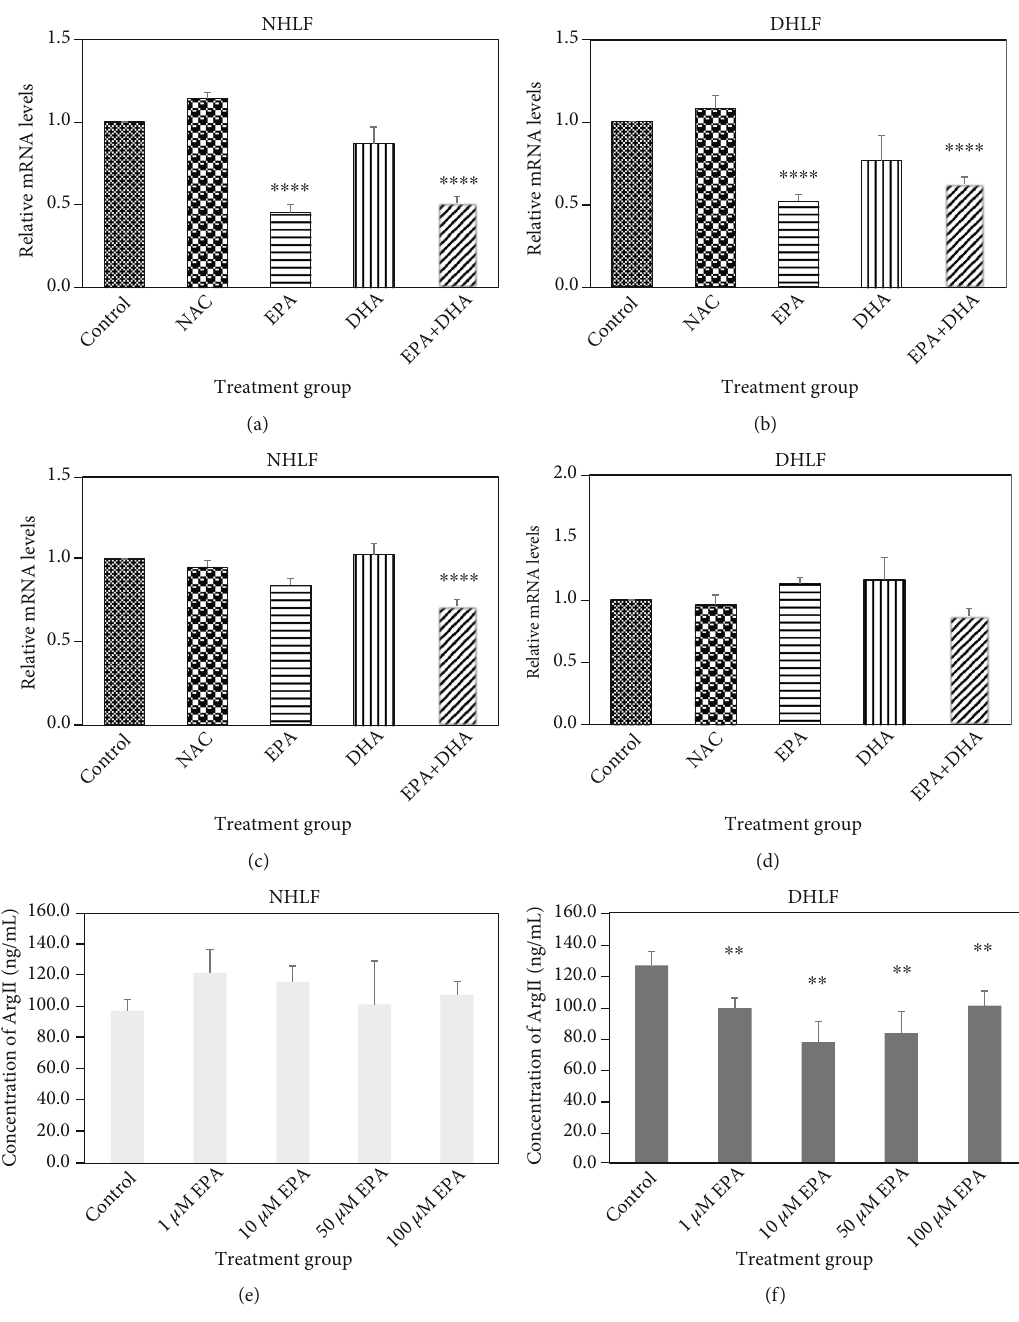
Figure 1: The e ff ects of ω -3 PUFAs on ARG2 and ODC mRNA levels and ARG2 protein levels in HLF. ARG2 (a and b) and ODC (c and d) mRNA levels were determined in NHLF (a and c) and DHLF (b and d). HLF were treated with 0.5mM NAC in combination with